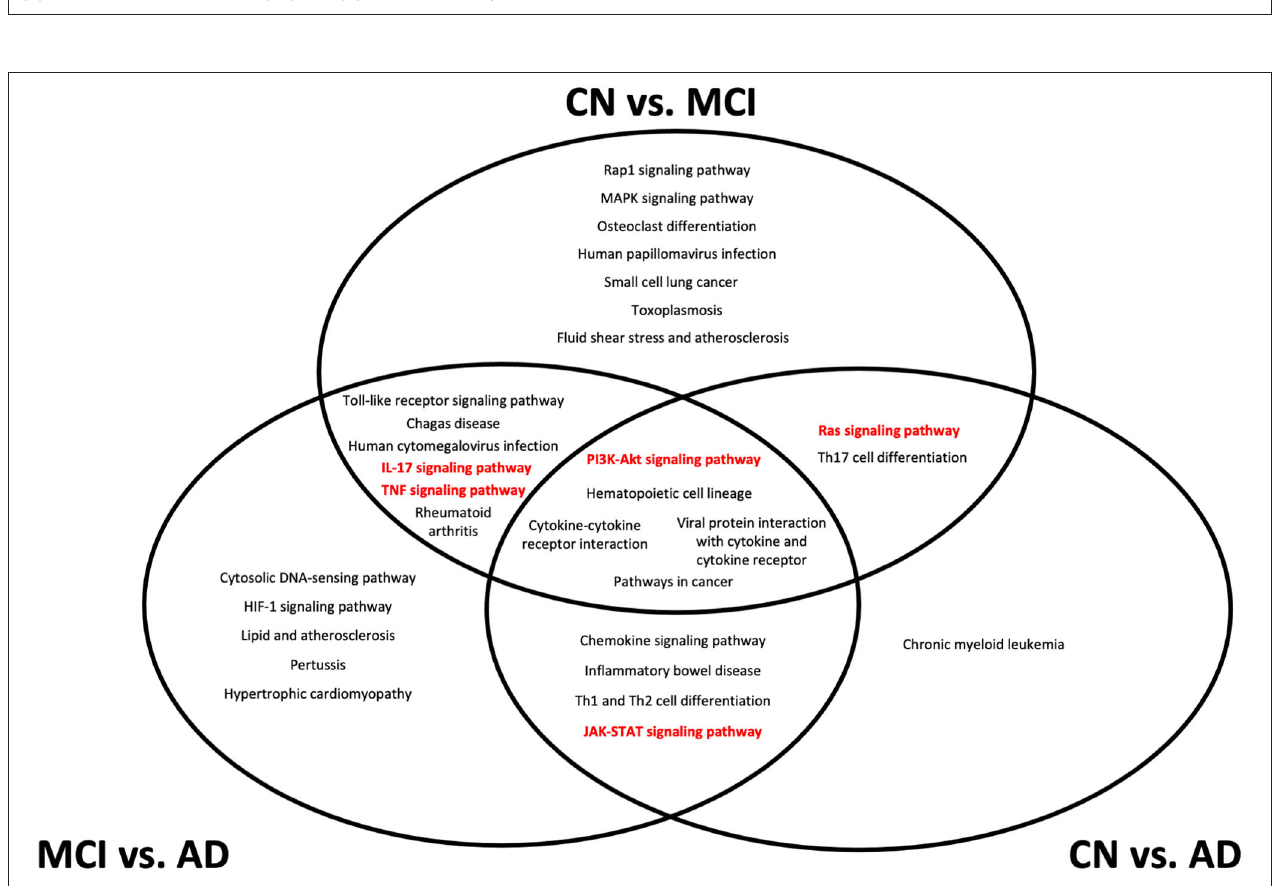
FIGURE 4 | Top 20 Kyoto Encyclopedia of Genes and Genomes (KEGG) pathways from gene set enrichment analysis of differentially expressed genes from each pairwise comparison. All pathways shown have an adjusted p < 0.05 from gene set enrichment analysis. Pathways that are considered as potential biomarker pathways, specifically the PI3K-Akt, IL-17, JAK-STAT, TNF, and Ras signaling pathways, are shown in red. CN, cognitively normal; MCI, mild cognitive impairment; AD, Alzheimer’s Disease.